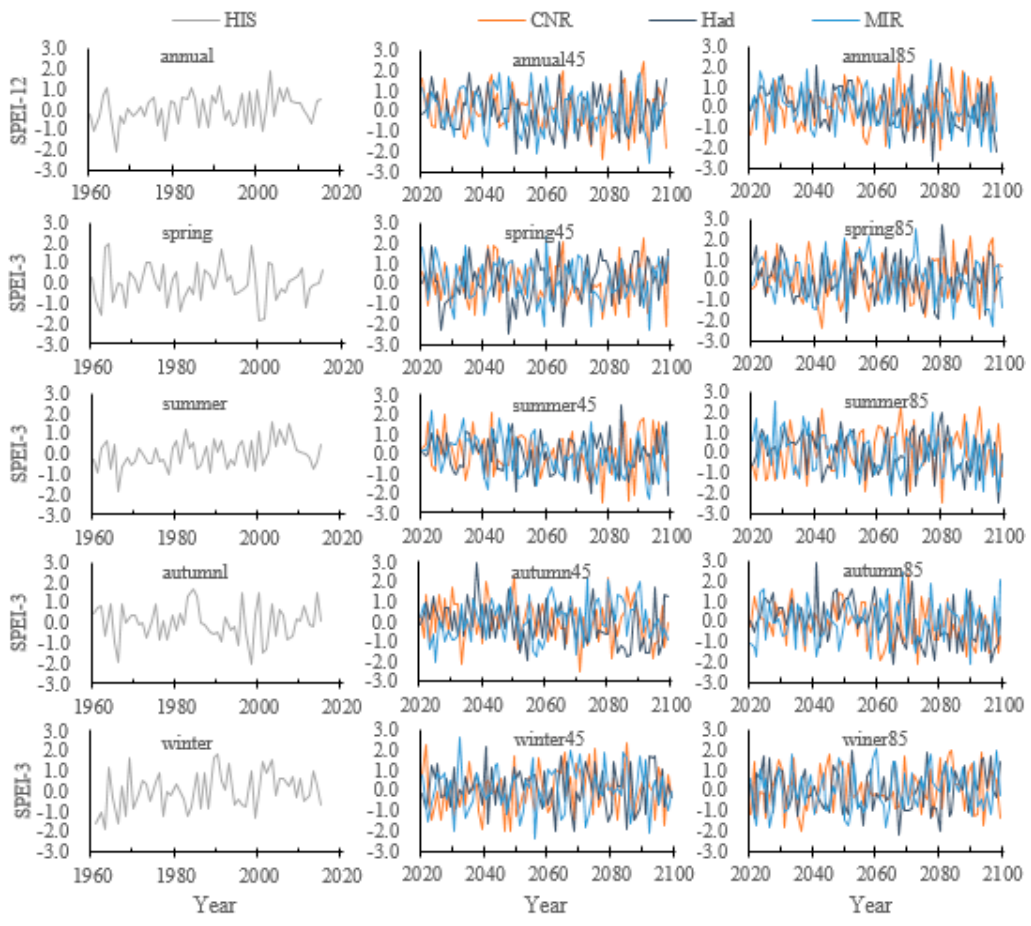
Figure 5. Changes of annual (SPEI-12) and seasonal (SPEI-3) drought indices historically and in the future. Table 6. The Mann-Kendall test for annual (SPEI-12) and seasonal (SPEI-3) drought indices historically and in the